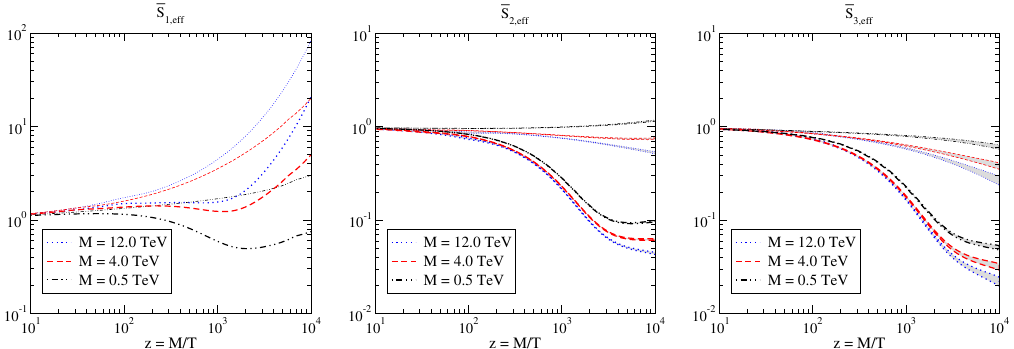
Figure 4 . Thin lines show the average Sommerfeld factors from eq. (5.4), as a function of z (cid:17) M=T , for (cid:1) M = 0; thick lines include the modi(cid:12)cations according to eqs. (5.7) and (5.8), with (cid:1) M (cid:17) 10 (cid:0) 3 M . For (cid:22) S the error band indicates the uncertainty as discussed around the end of 2 ; 3 section 4.2. For large z , (cid:22) S increases because of the emergence of bound-state like structures 1